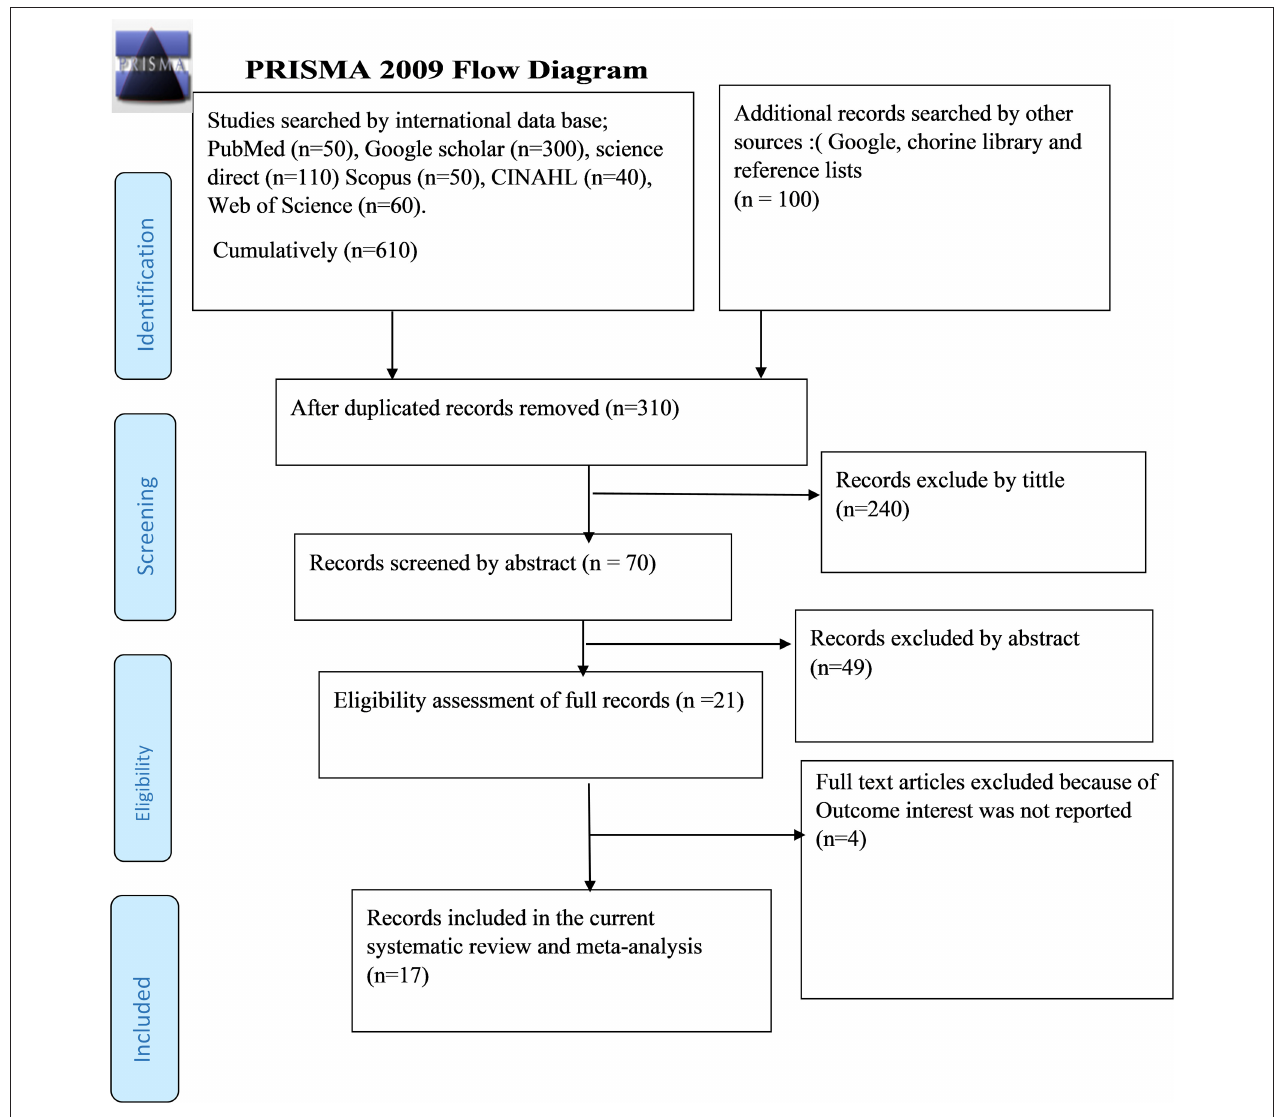
FIGURE 1 | Flow diagram of studies included in systematic review and